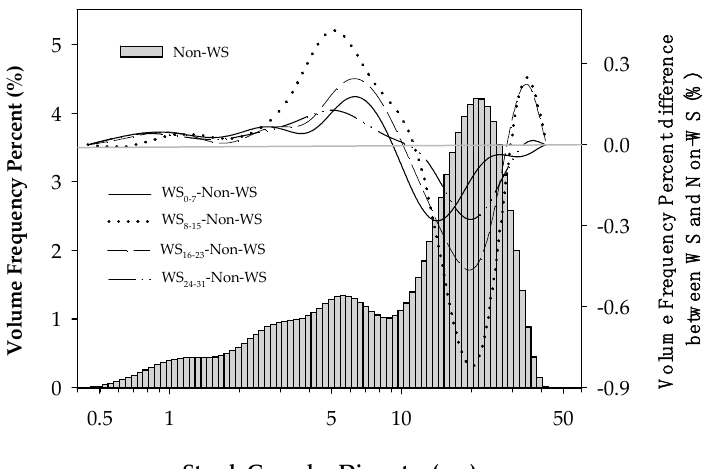
Figure 1. Effects of post-anthesis combined waterlogging and shading stress on the starch granule size distribution in the endosperm of mature wheat grains. WS–Non-WS indicates the difference of volume frequency percent distribution profile of the starch granules between WS and Non-WS.